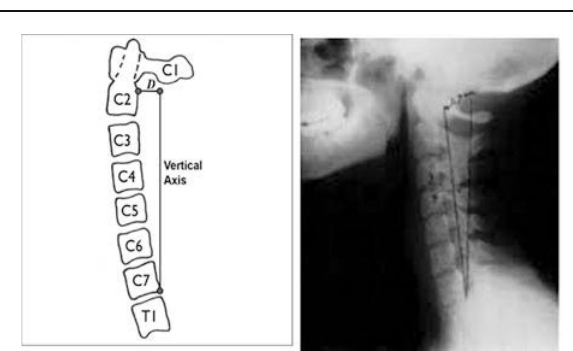
Anterior head displacement measured as horizontal distance (D) between posterior – superior body of C2 vertebra and vertical line drawn superiorly from posterior – inferior body of C7 vertebra. T1 = first thoracic vertebra, C1 – C7 = first to seventh cervical